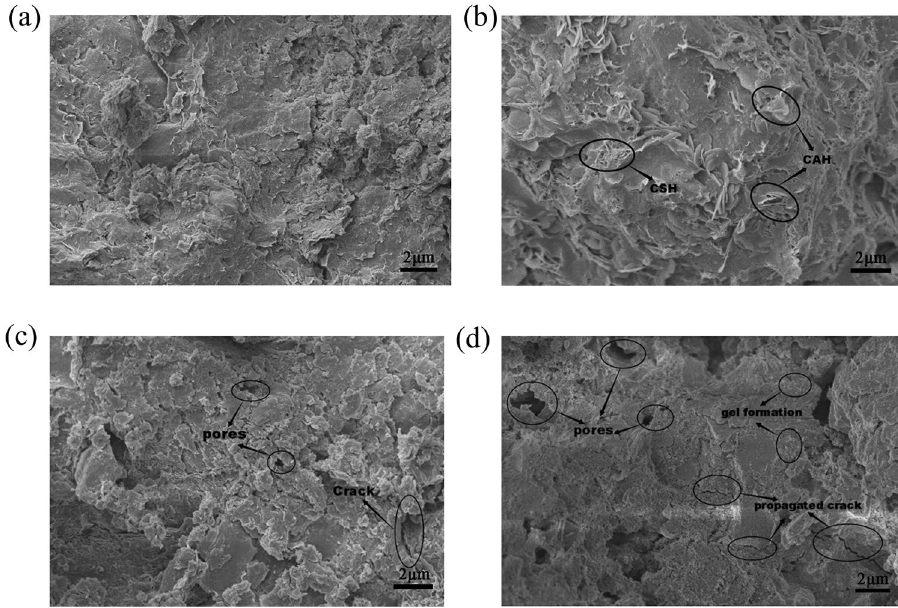
Figure 6. SEM images of 5000 mg/kg chromium contaminated soil specimens after different dry wet cycles at ( a ) 0 times; ( b ) 2 times; ( c ) 8 times; and ( d ) 16 times.